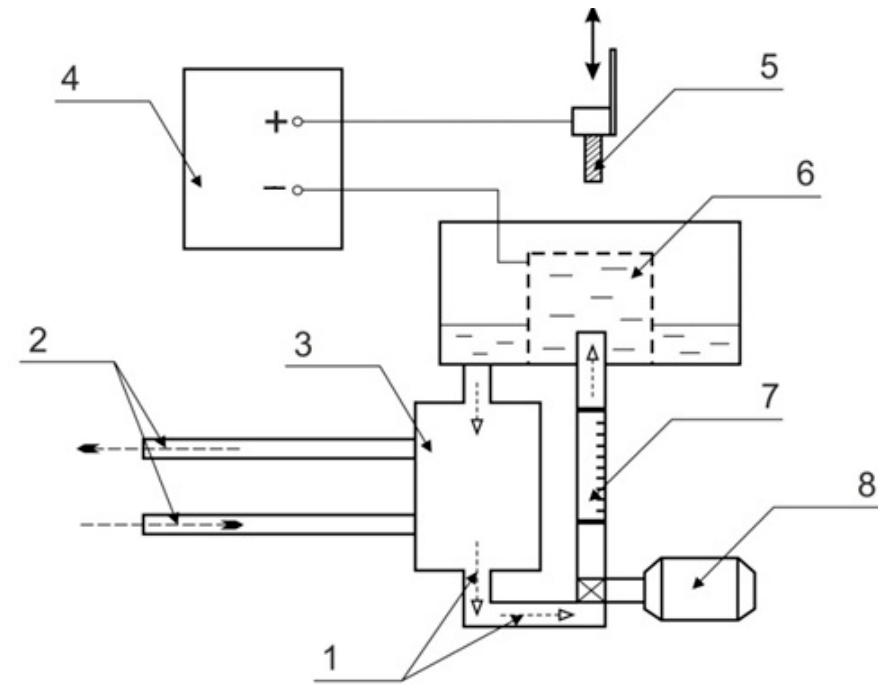
Figure 1. Schematic diagram of setup for anodic PENC and PEP: 1—electrolyte; 2—cold/hot water; 3—heat exchanger; 4—power supply; 5—treated sample; 6—electrolytic cell; 7—flowmeter; 8—pump.